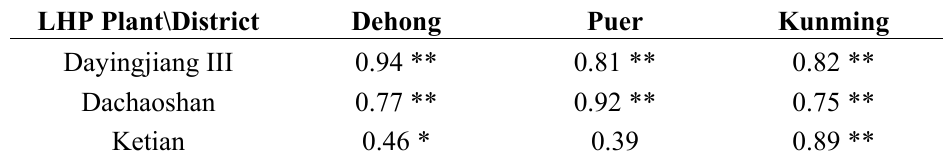
Table 1. The correlation coefficient between SHP and LHP plants in a district.